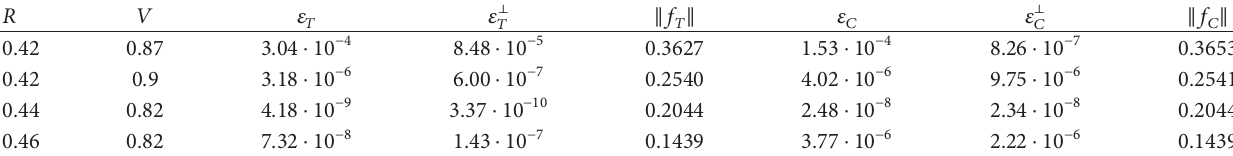
Table 2: Result enforcing 𝑅 , 𝑉 and tangential